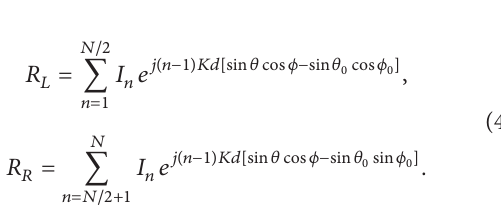
Figure 3: Geometry of an 𝑁 -element linear array along the 𝑥 -axis.